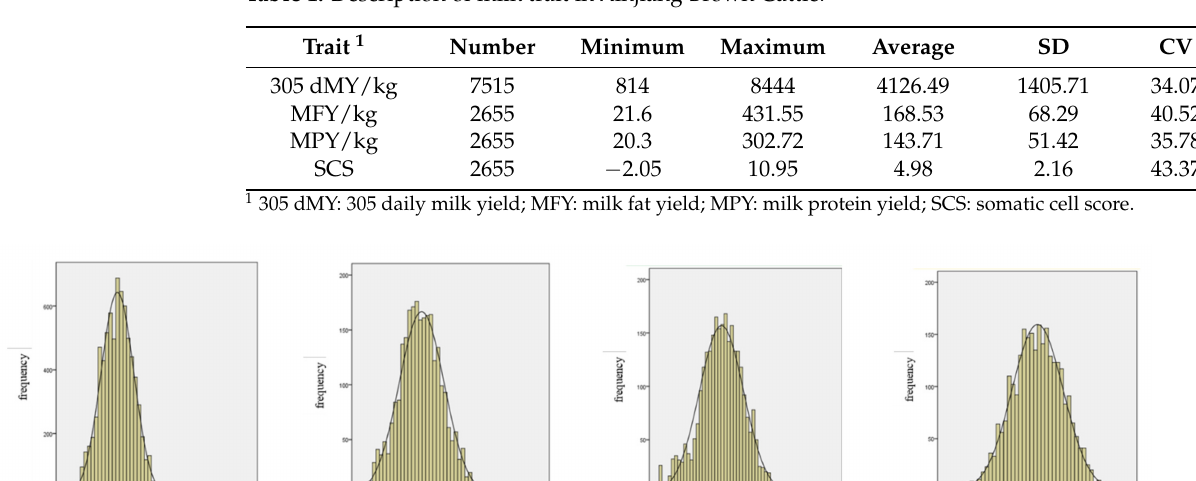
Table 1. Description of milk trait in Xinjiang Brown Cattle.